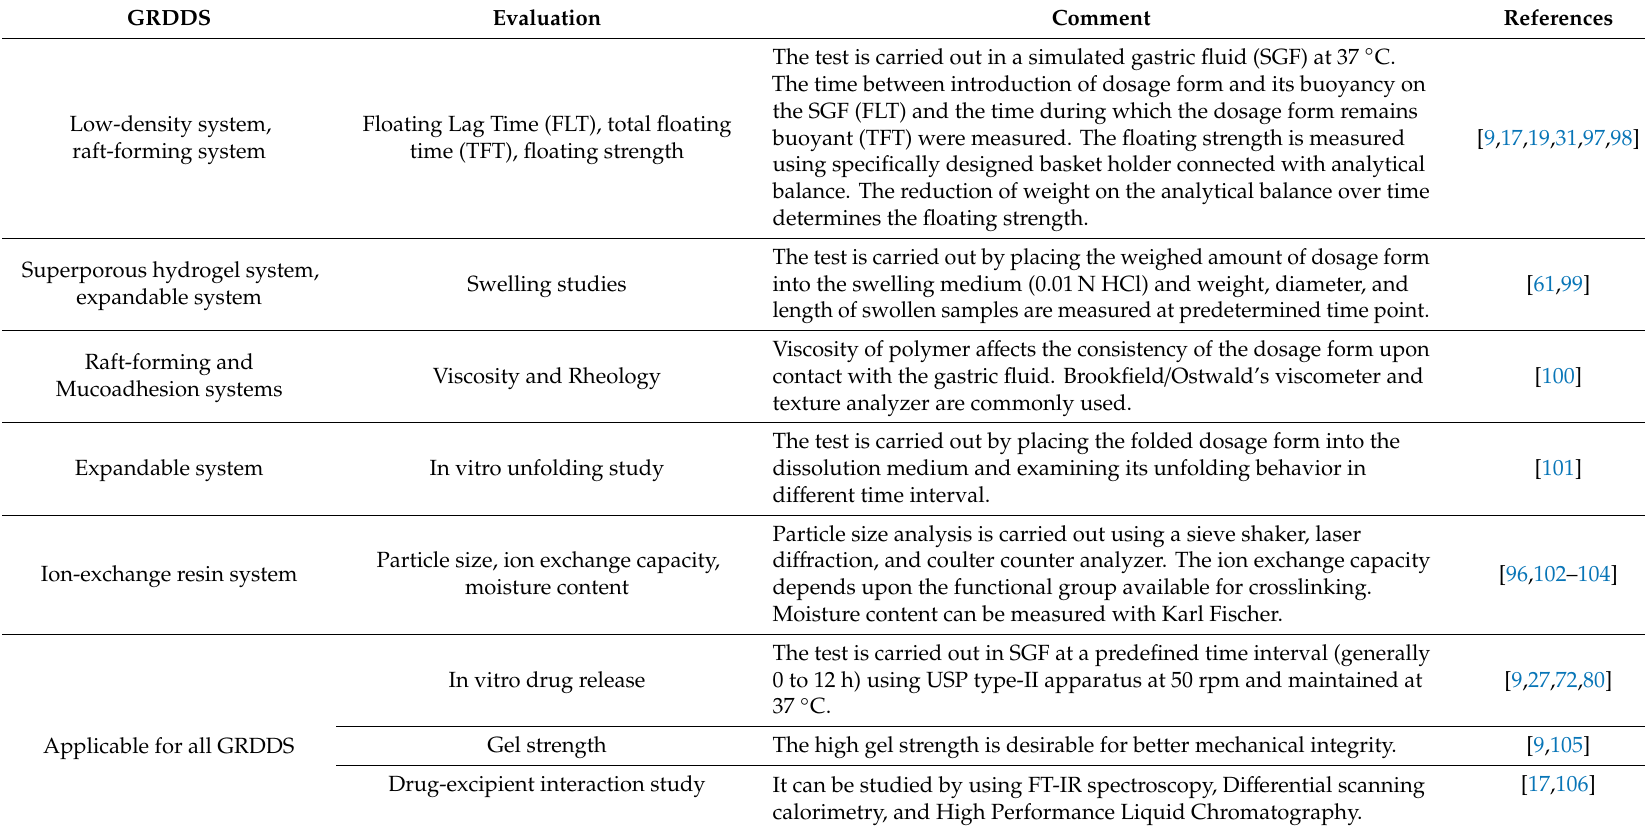
Table 6. In vitro evaluation parameters of various